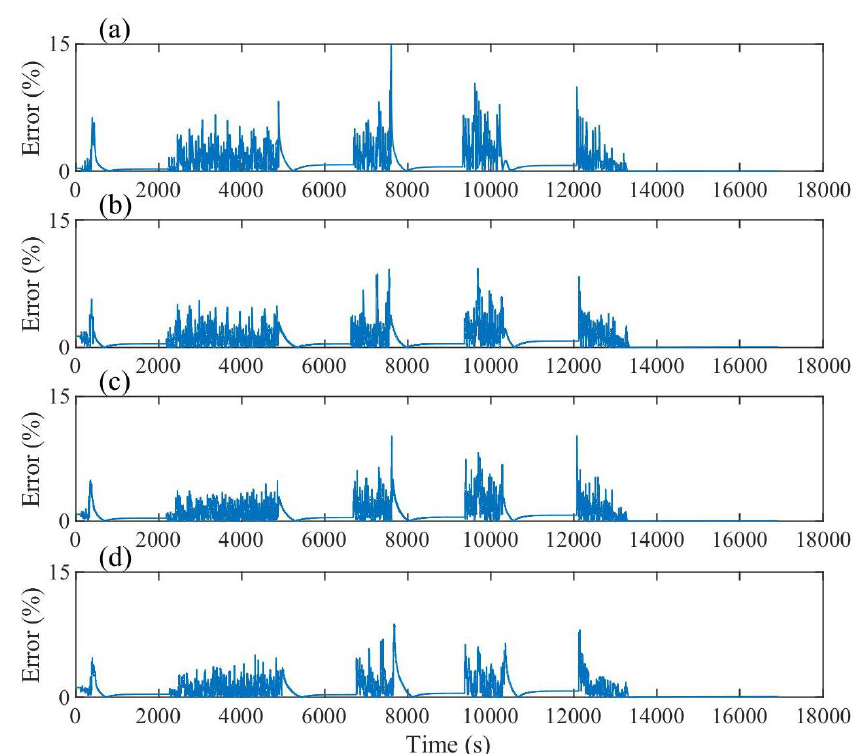
Figure 10. SOC estimation error of the DST profile in the four modes: ( a ) first mode, ( b ) second mode, ( c ) third mode, and ( d ) fourth